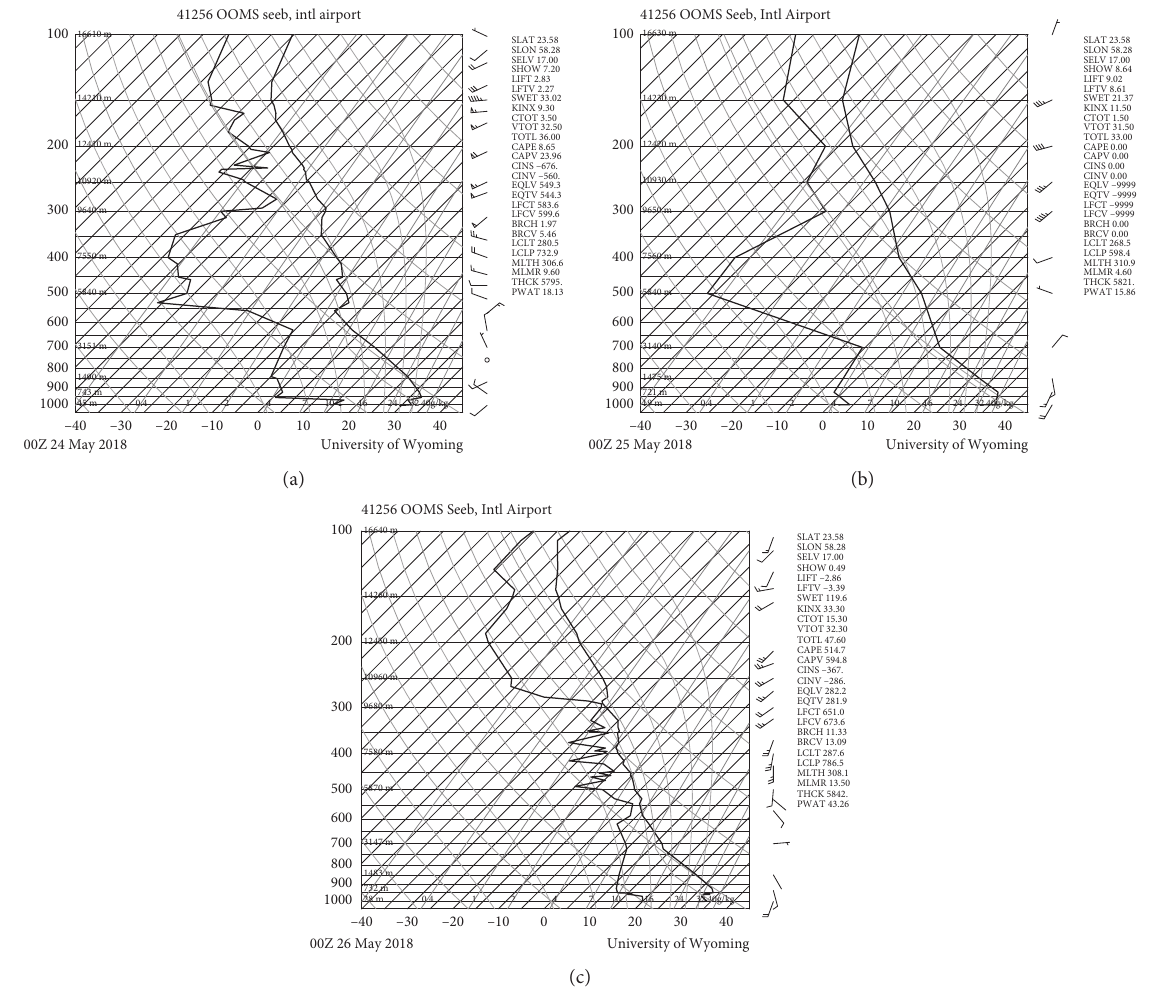
Figure 16: The upper air sounding on (a) 24th of May 2018, (b) 25th of May 2018, and (c) 26th of May 2018 (source: University of Wyoming, 2018).